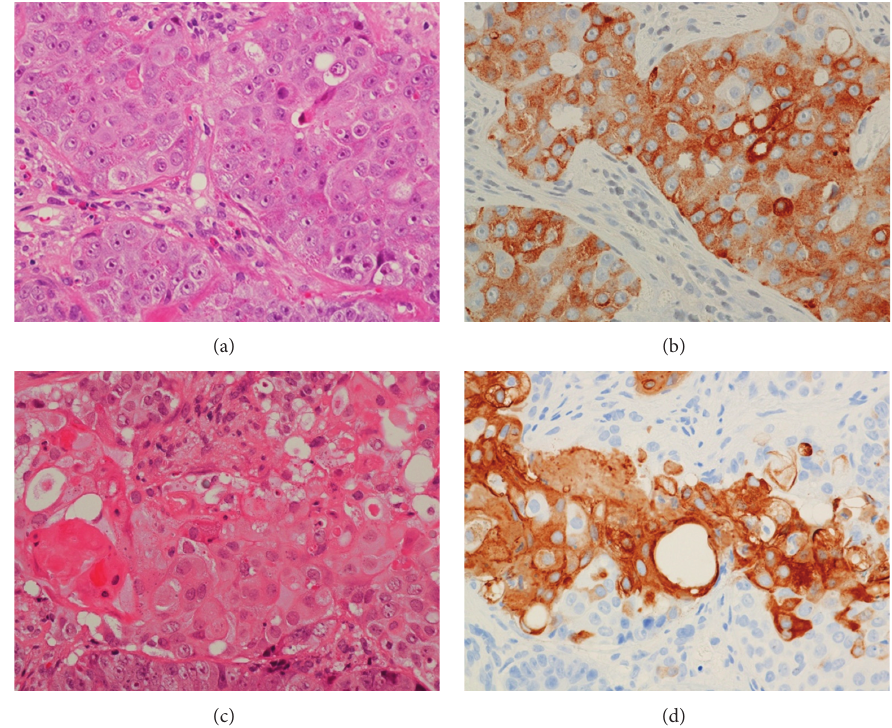
Figure 3: Histology of LCNEC with squamous cell carcinoma. (a) HE stain shows that tumor cells with trabecular patterns possess prominent nucleoi and large nuclei and a moderate amount of cytoplasm with eosinophil granule. (b) Synaptophysin is positive in the LCNEC. (c) HE stain shows squamous cancer cells without any keratin pearl. (d) The invasive tumor nests have 34bE12 positive neoplastic squamous